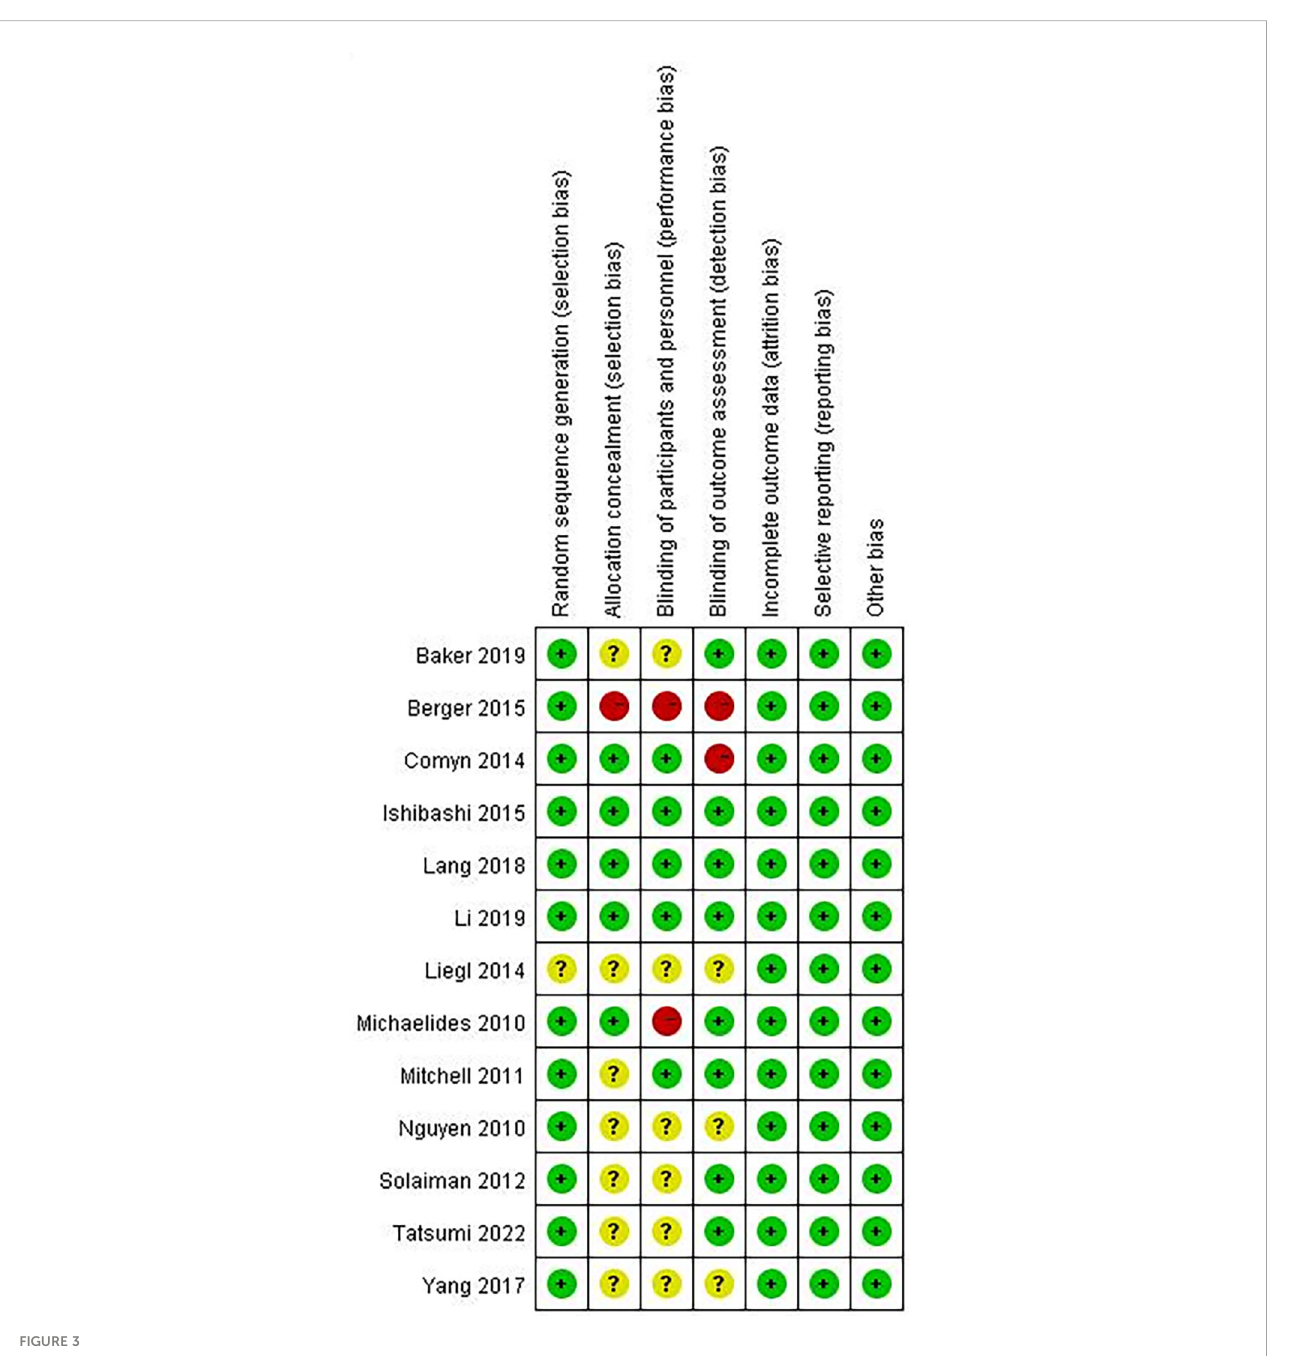
FIGURE 3 Risk of bias